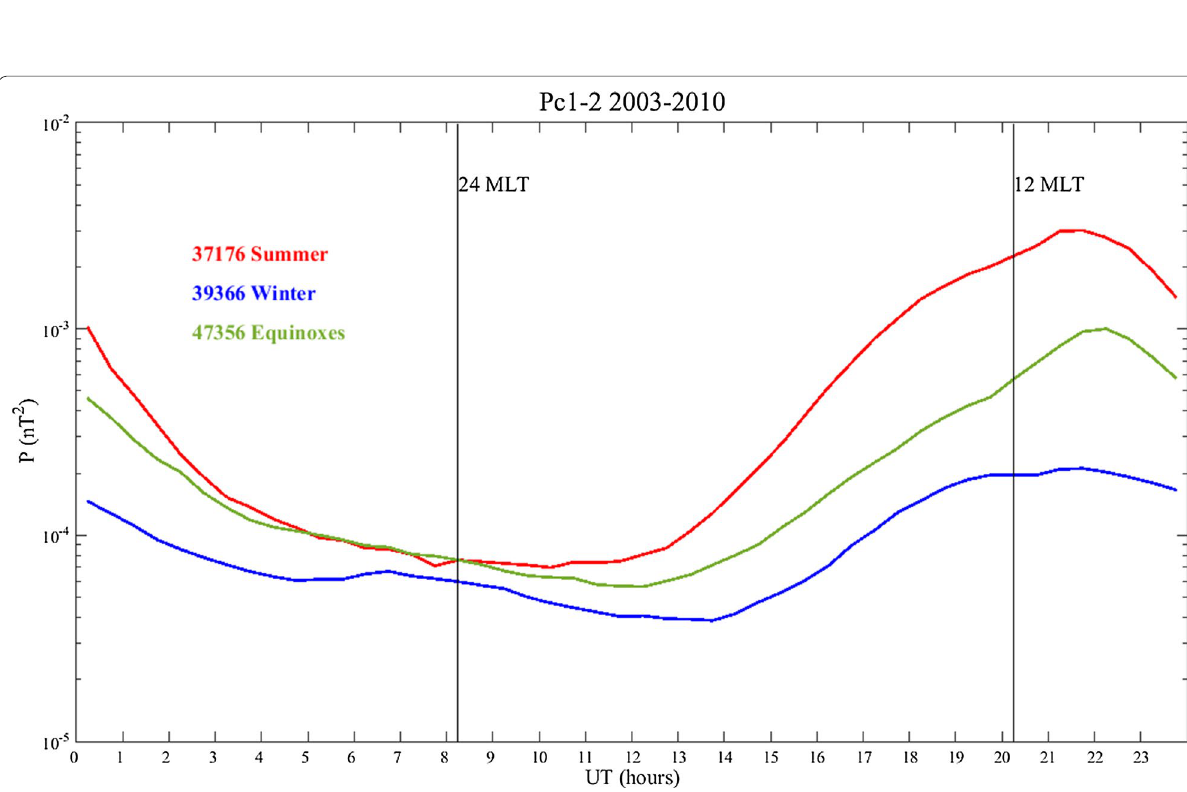
Fig. 3 Daily variations in power. The UT dependence on the average P value from 2003 to 2010, separately for local summer (red line), winter (blue line), and equinoctial (green line) months. The number of spectra in each average is